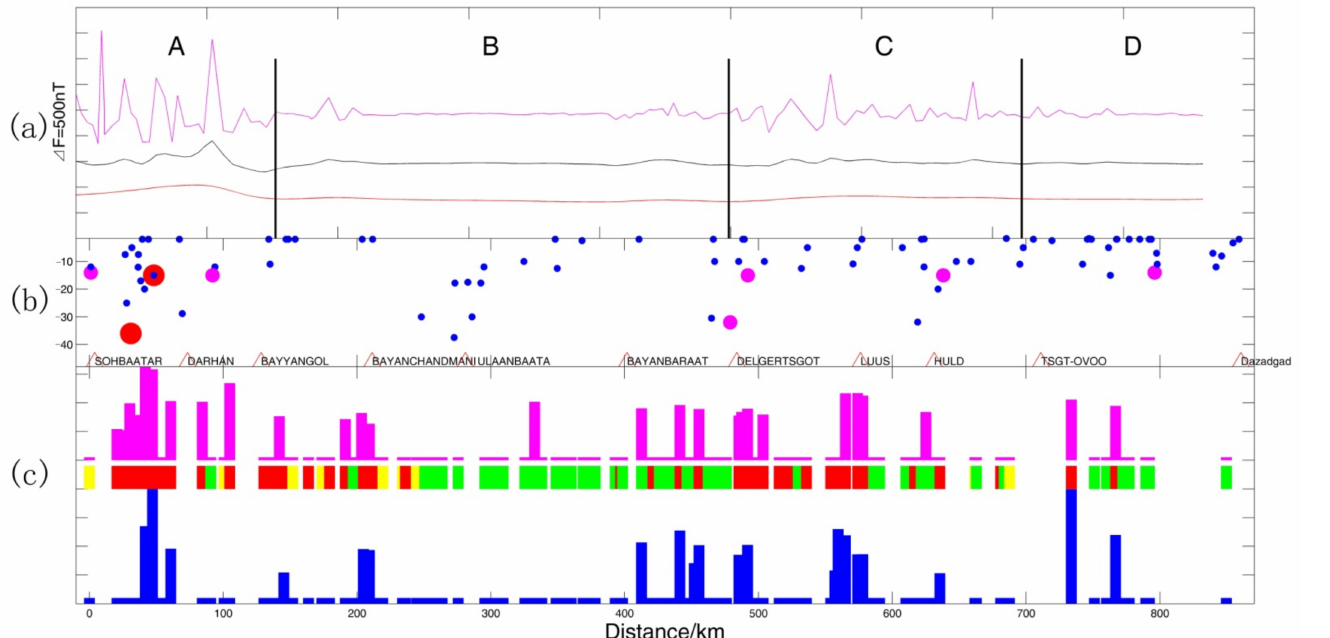
Figure 4. Comparison of comprehensive information on geophysics, geological structure, and other aspects along the SD profile in Mongolia. ( a ) The decomposition characteristics of the lithospheric magnetic field. The pink curve, black curve, and red curve represent the superficial surface part f s , middle layer part f m , and basement part f b , respectively. ( b ) The solid circle displays the size and depth of earthquakes within 100 km of the SD profile: The solid red circles, solid pink circles, and solid blue circles represent earthquakes with magnitude 6 or higher, earthquakes with magnitude 5–6, and earthquakes with magnitude 3–5, respectively. The red triangles indicate cities. ( c ) The lithology, magnetic susceptibility, and remanent magnetization of rock samples. The pink and blue columns represent the magnetic susceptibility and remanent magnetization values of the rock samples, respectively. The red column, green column, and yellow column represent magmatic rocks, sedimentary rocks, and metamorphic rocks,